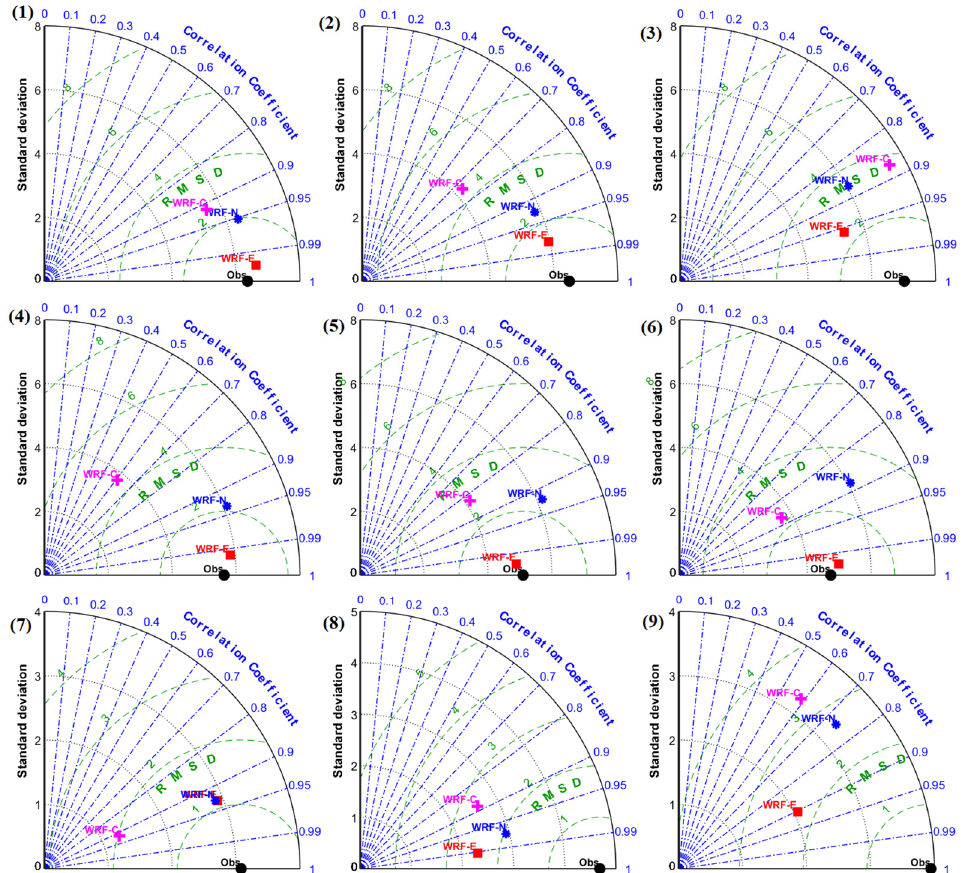
Figure A12. Daily average temperature in K from the models and observations at the locations ( a ) Dongsha, ( b ) Zhanjiang, and ( c ) Hong Kong.